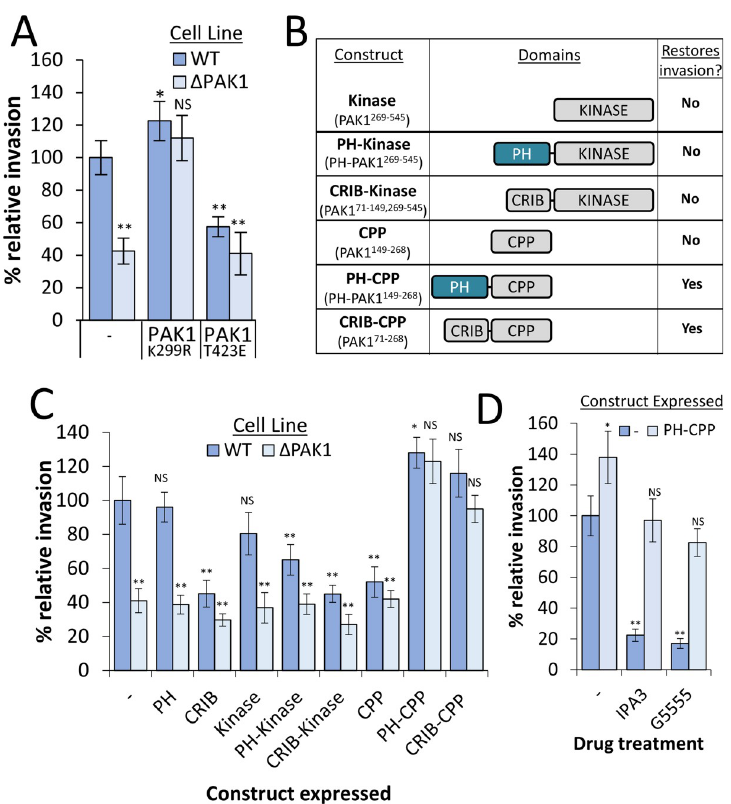
Fig 3. PAK kinase and central polyproline domain have opposing effects on Salmonella invasion. (A) Invasion of WT Salmonella (20 mins) into WT or Δ PAK1 Hap1 cells expressing the indicated construct: control (-), kinase dead PAK1 (PAK1 K299R ) or constitutively active kinase PAK1 (PAK1 T423E ). Invasion values relative to control WT Hap1 cells. (B) Table summarising PAK1 constructs and their effect on invasion in Δ PAK1 cells, from the data in (C) . PAK1 kinase domain (kinase), the kinase domain fused to a PH domain (PH-Kinase), CRIB/AID fused to kinase domain (CRIB-Kinase), central polyproline domain (CPP), CPP fused to a PH domain (PH-CPP) and CRIB/AID, CPP (CRIB-CPP). (C) WT Salmonella invasion (20 mins) into WT and Δ PAK1 Hap1 cells expressing the indicated construct, outlined in (B) . Invasion values relative to control WT Hap1 cells. (D) WT Salmonella invasion (20 mins) into control WT Hap1 cells (-) or the same expressing PH-CPP (+ PH-CPP). Cells were pretreated with either DMSO (control) or one of the PAK inhibitors IPA3 or G5555. Invasion values relative to control WT Hap1 cells. All Error bars indicate SD. NS–no significant difference, �� —P < 0.01, � P < 0.05 (ANOVA followed by a post hoc Dunnett’s